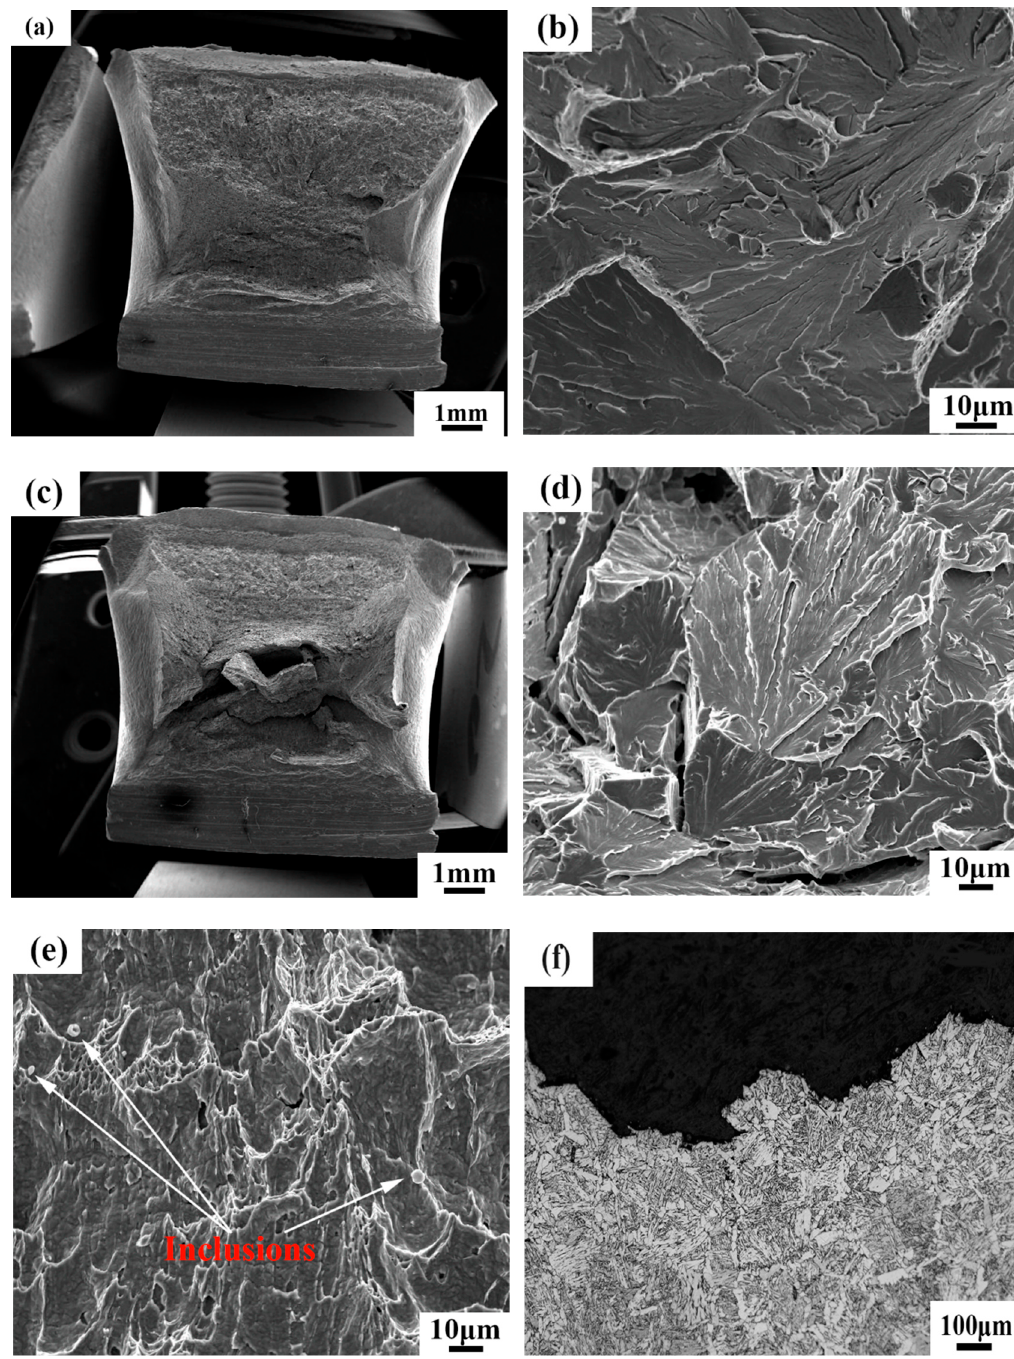
Figure 4. SEM images of the fracture surface and the microstructure adjacent to the fracture surface in ( a , b ) plain EH420; and ( c – f ) EH420-Mg. ( a , b ) plain EH420; and ( c – f )